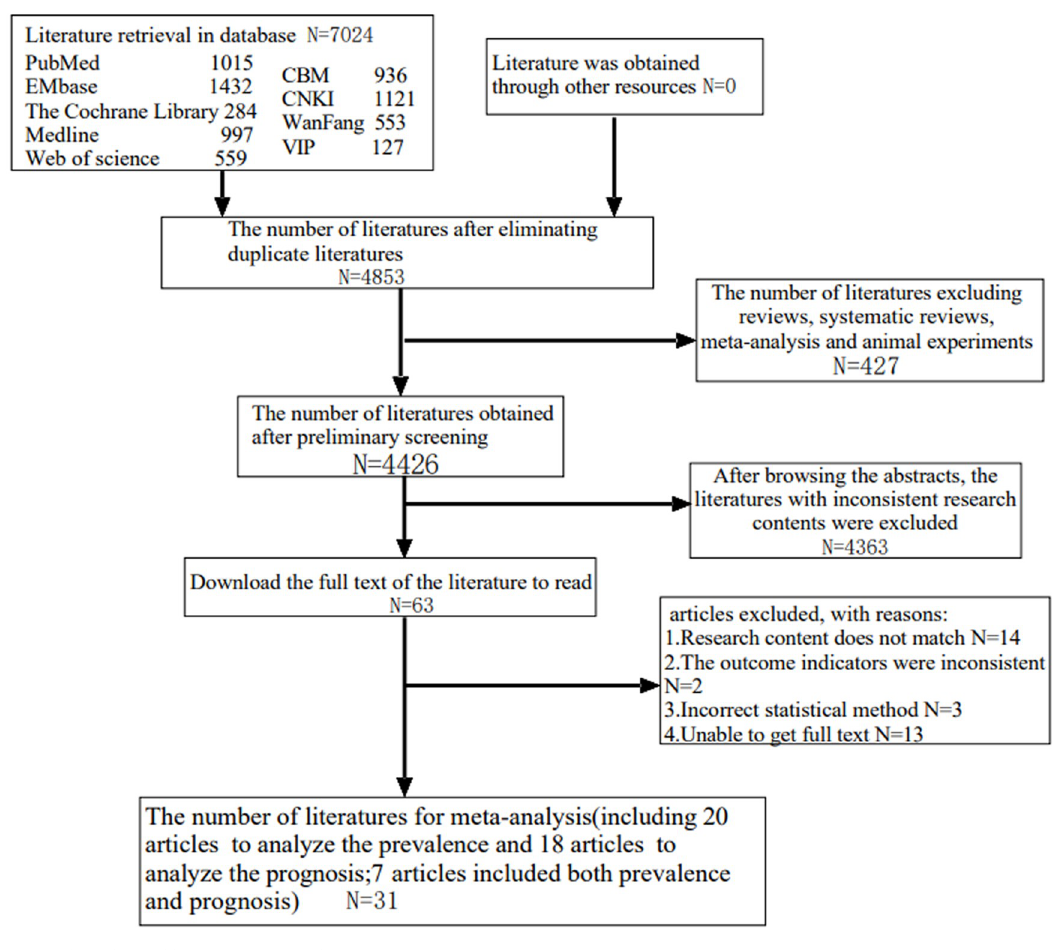
Fig 1. Flow chart of literature